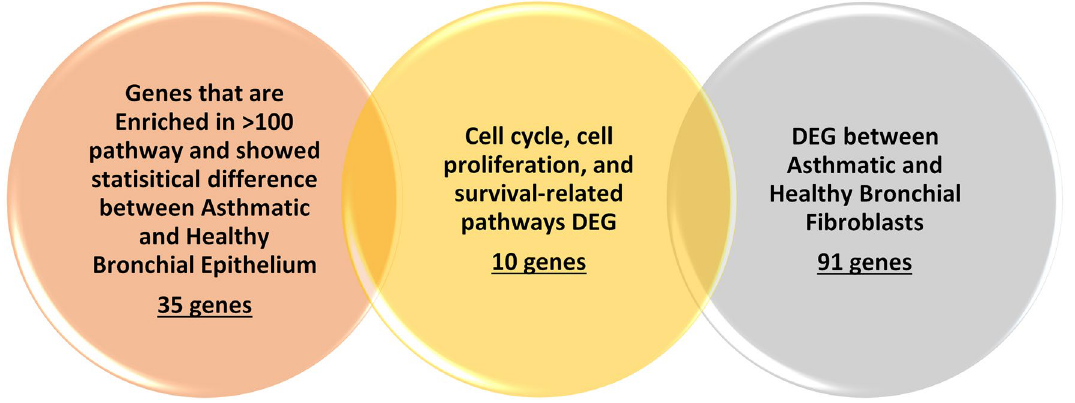
Figure 1. Schematic representation of the filtering of Genes Identified using our bioinformatic pipeline showing the resultant gene list that shares a common pathway mainly related to cell cycle, cell proliferation, and